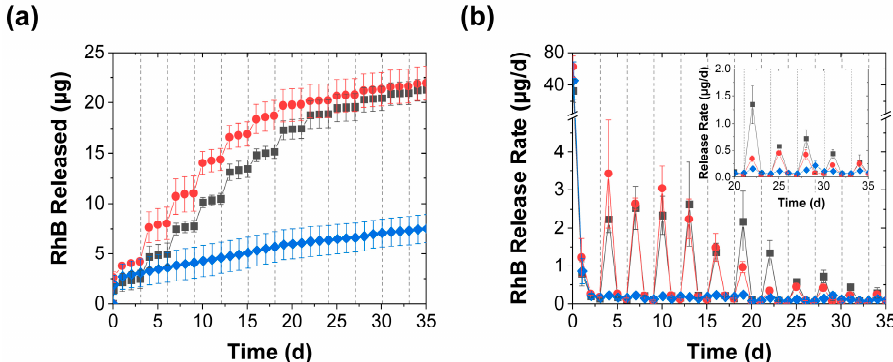
Figure 2. RhB release from coacervates into deionized water achieved with ( ■ ) periodic perforation by five needle jabs, ( • ) periodic compression, and ( (cid:7) ) without mechanical stimulation and shown in terms of both ( a ) the total RhB mass released and ( b ) the release rate (mean ± SD). The inset provides a closeup of the slower release rates near the end of the experiment. The coacervates in this experiment were stimulated every 3 d using either five needle jabs or a spatula. The solid lines are guides to the eye, while the dashed vertical lines mark the mechanical stimulation times.